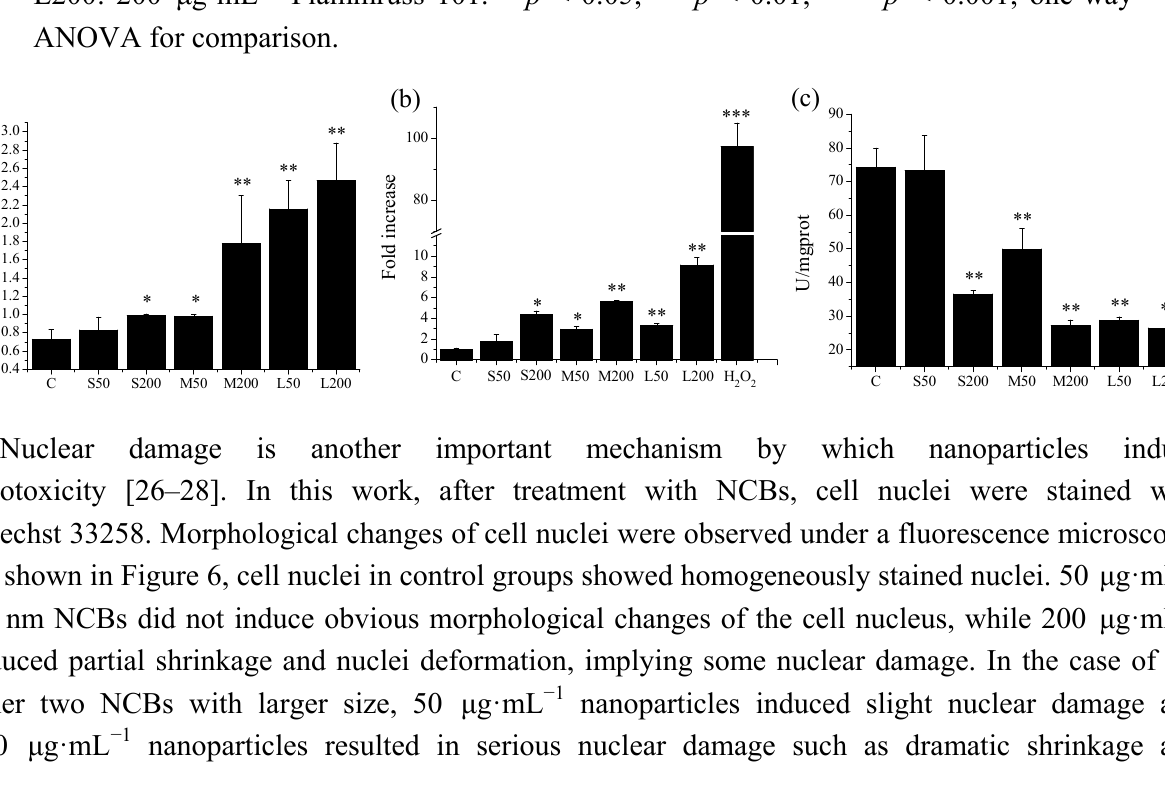
Figure 5. NCBs-induced oxidative stress in RAW264.7 cells. ( a ) MDA level; ( b ) ROS level; ( c ) SOD level. C: control; S50: 50 μ g·mL − 1 Printex 90; S200: 200 μ g·mL − 1 Printex 90; M50: 50 μ g·mL − 1 Printex G; M200: 200 μ g·mL − 1 Printex G; L50: 50 μ g·mL − 1 Flammruss